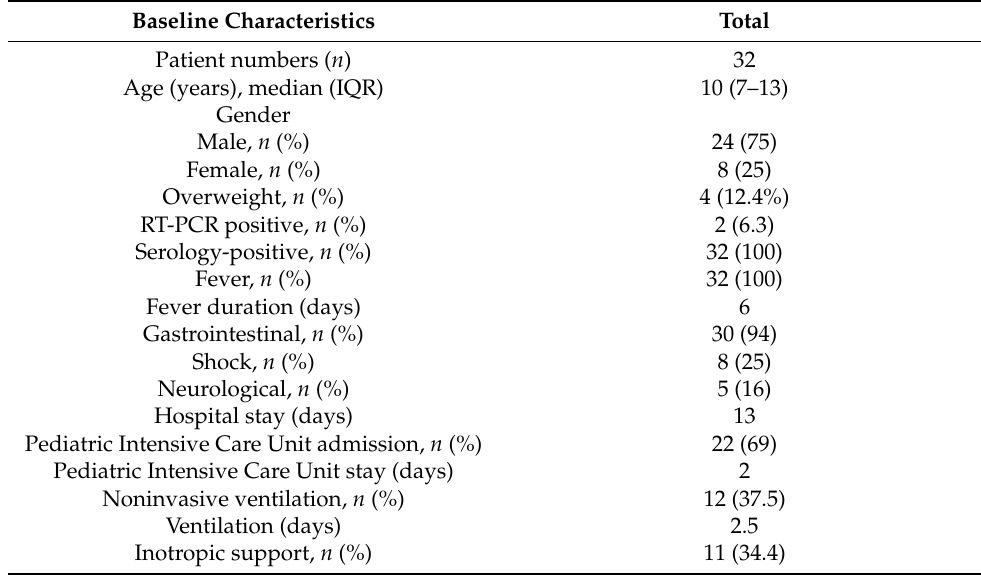
Table 1. Baseline characteristics of the population, according to the degree of compromised myocar- dial